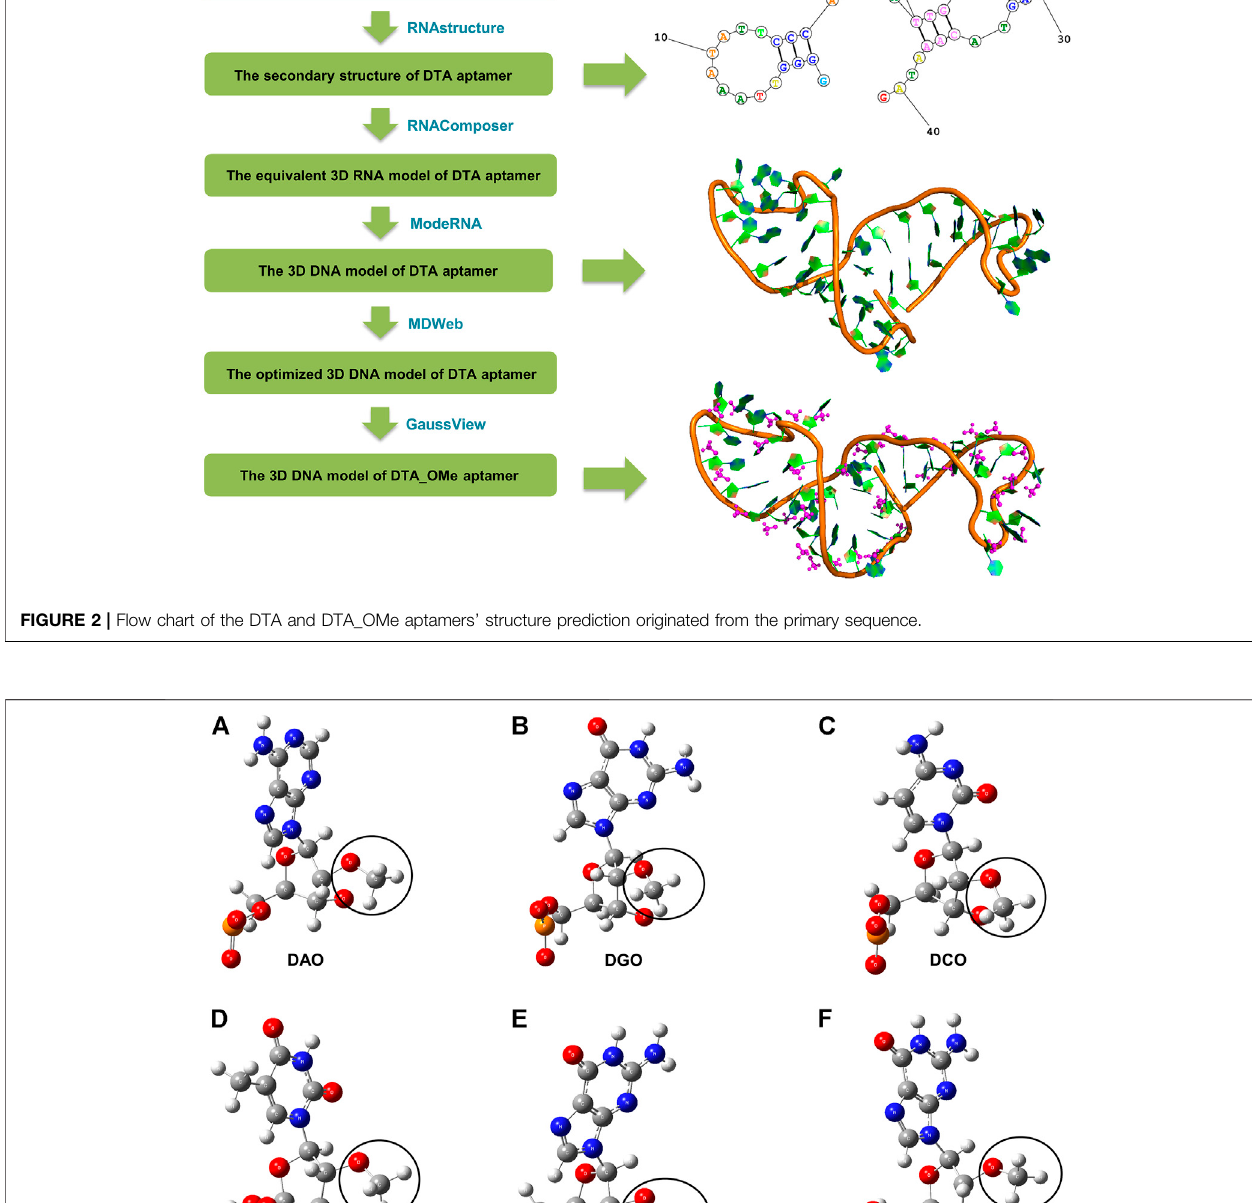
Frontiers in Molecular Biosciences |